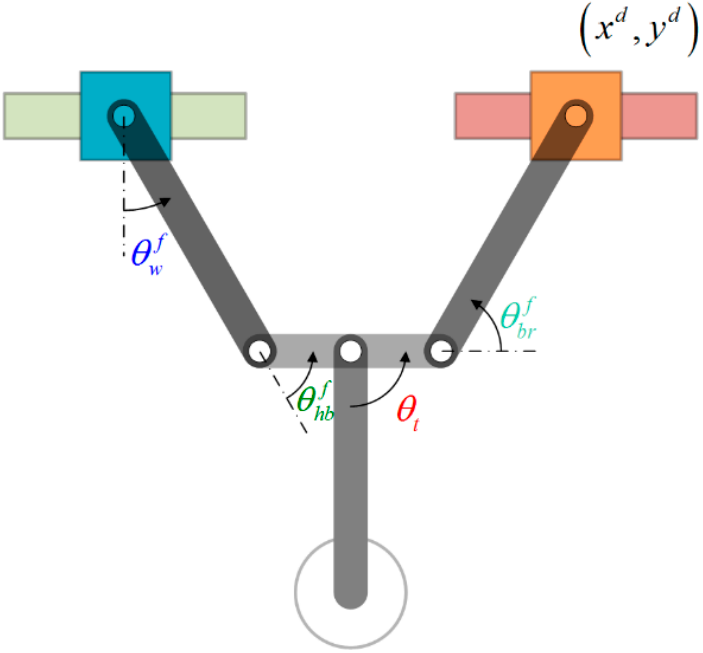
Figure 11. Robot posture best suited to grasping the target ledge.